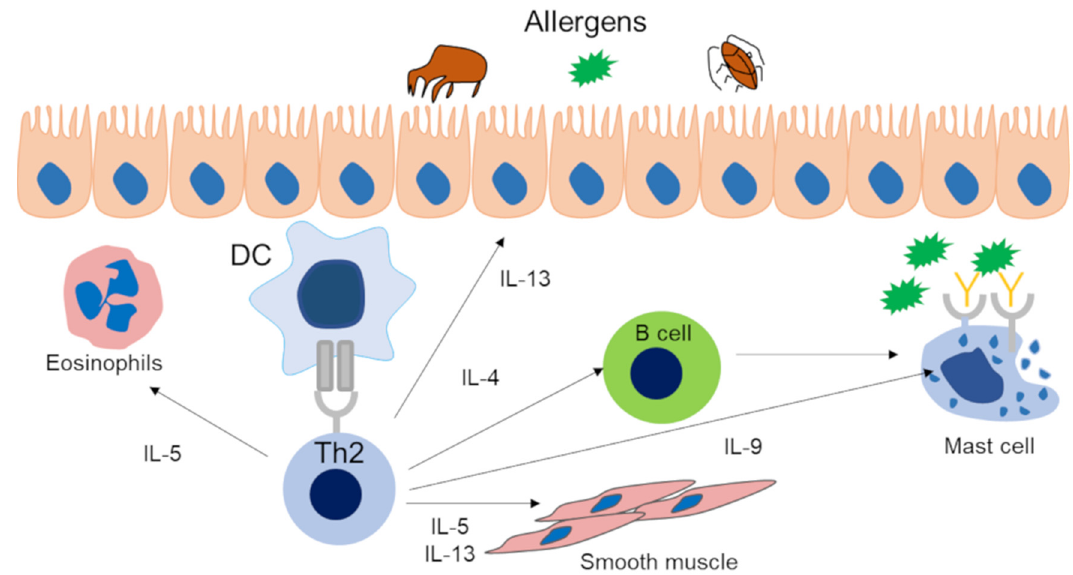
Figure 1. Type 2 immune response via Th2 lymphocytes in asthma patients. Dendritic cells capture inhaled antigens and present them to CD4-positive T cells via the T cell receptor. As a result, cytokines such as IL-4, IL-5, IL-9, and IL-13 are released from Th2 cells. IL-4 is involved in the differentiation of B cells into IgE-producing cells. IL-5 causes eosinophil activation and tissue eosinophilia. IL-9 is involved in mast cell proliferation. IL-13 causes goblet cell metaplasia. IL-5 and IL-13 cause bronchial hyperreactivity. DC, dendric cell; Th2, T helper 2 cell.